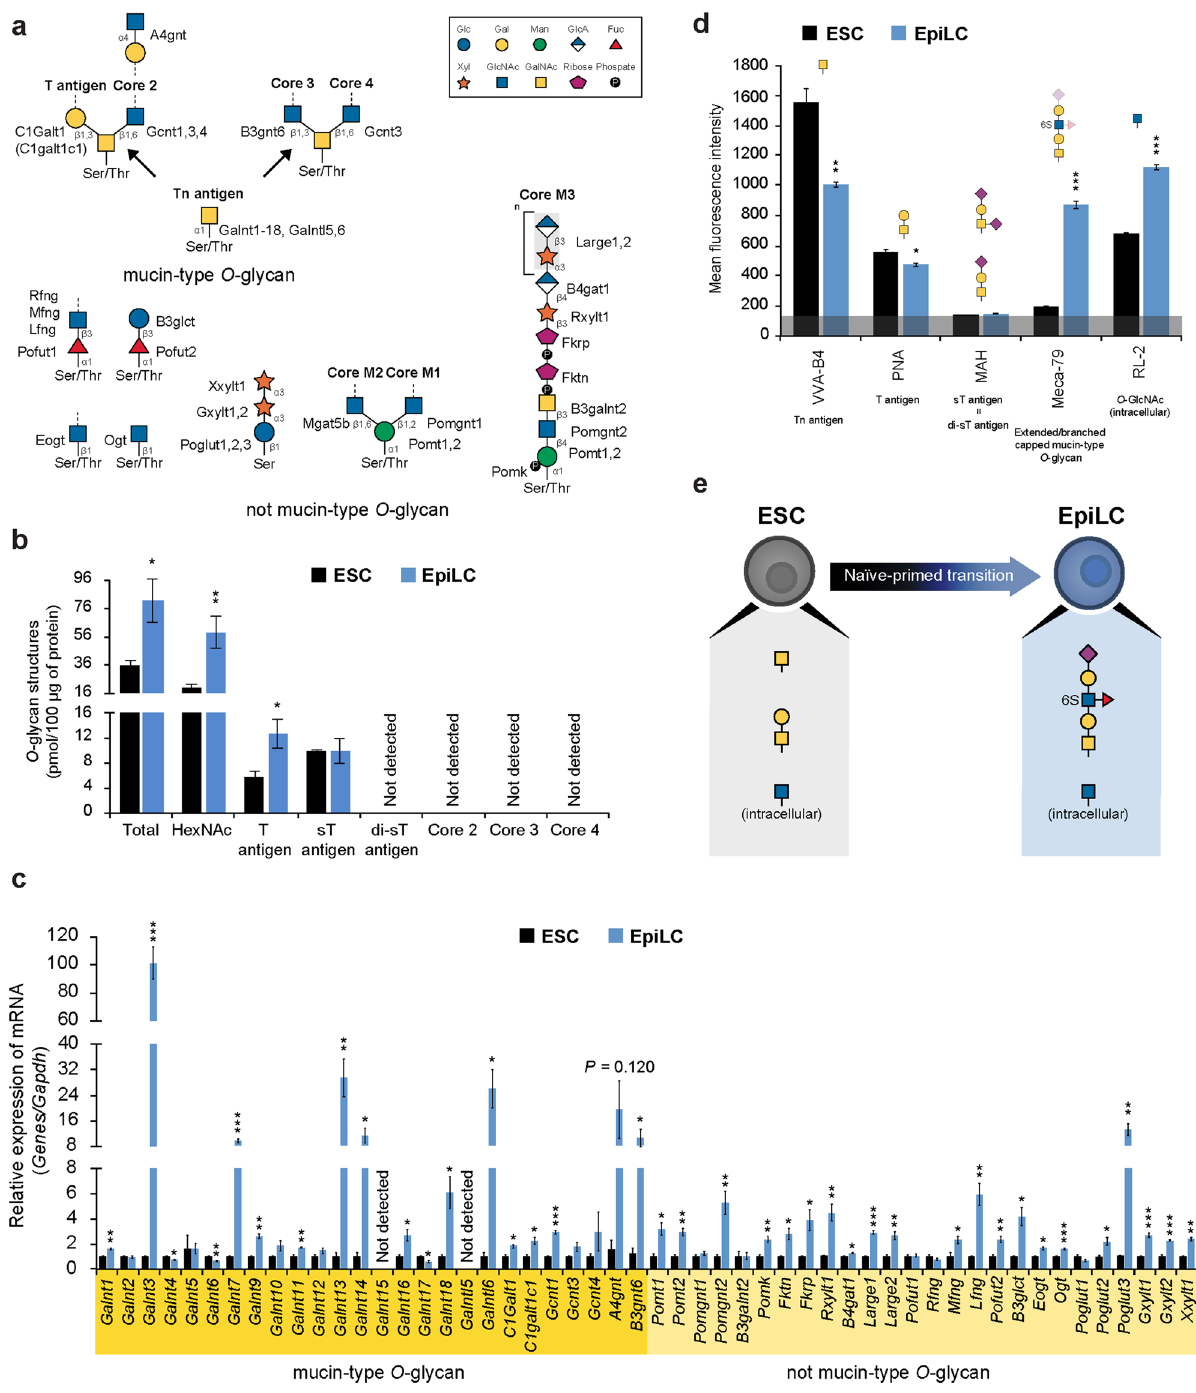
Figure 3. ESC and EpiLC O -glycosylation structural and transcriptional analysis. ( a ) Schematic diagram of the O -glycosylation pathway. ( b ) Absolute amount of O -glycans detected by MS in ESCs and EpiLCs. HexNAc: GalNAc or GlcNAc. ( c ) Real-time PCR analysis of O -glycosylation-specific enzymes normalized against Gapdh in ESCs and EpiLCs, and shown as a fold change relative to ESCs. ( d ) O -glycan structure profiling by FACS using specific lectins/Abs in ESCs and EpiLCs. Lectin/Ab specificities are stated below the labels and schematically represented above each histogram. The grey line at the bottom represents the negative control staining. ( e ) Model of O -glycome changes during ESC to EpiLC transition. Values are shown as means ± s.e.m. of three independent experiments in ( c , d ) and four independent experiments in ( b ). Significant values are indicated as * P < 0.05, ** P < 0.01, and *** P <